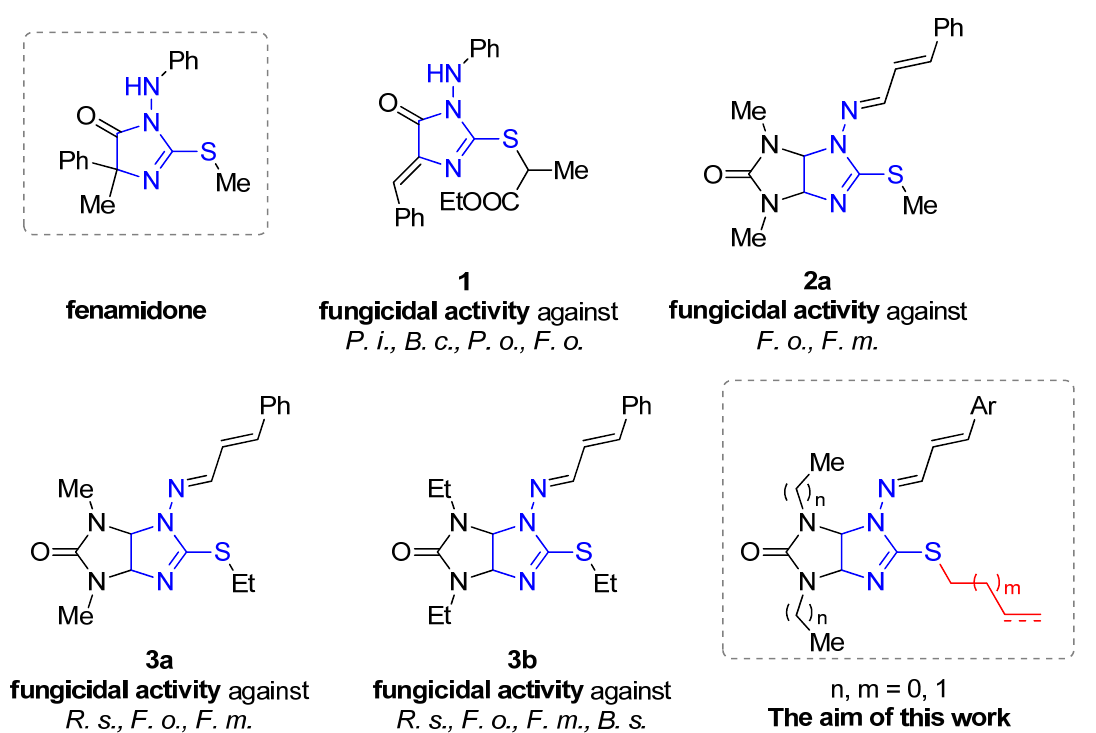
Figure 1. S-alkyl derivatives of imidazolidinethione and thioglycoluril possessing fungicidal activity against Phytophthora infestans ( P. i .), Botrytis cinerea ( B. c .), Pyrcularia oryzae ( P. o .), Fusarium oxysporum ( F. o .), Fusarium moniliforme ( F. m .), Rhizoctonia solani ( R. s .), and Bipolaris sorokiniana ( B. s .) and the aim of this work.